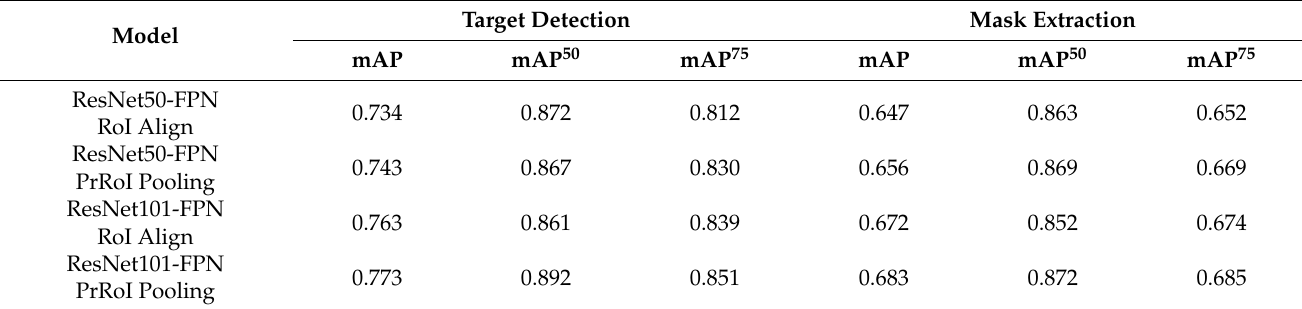
Table 3. Model performance obtained with different pooling